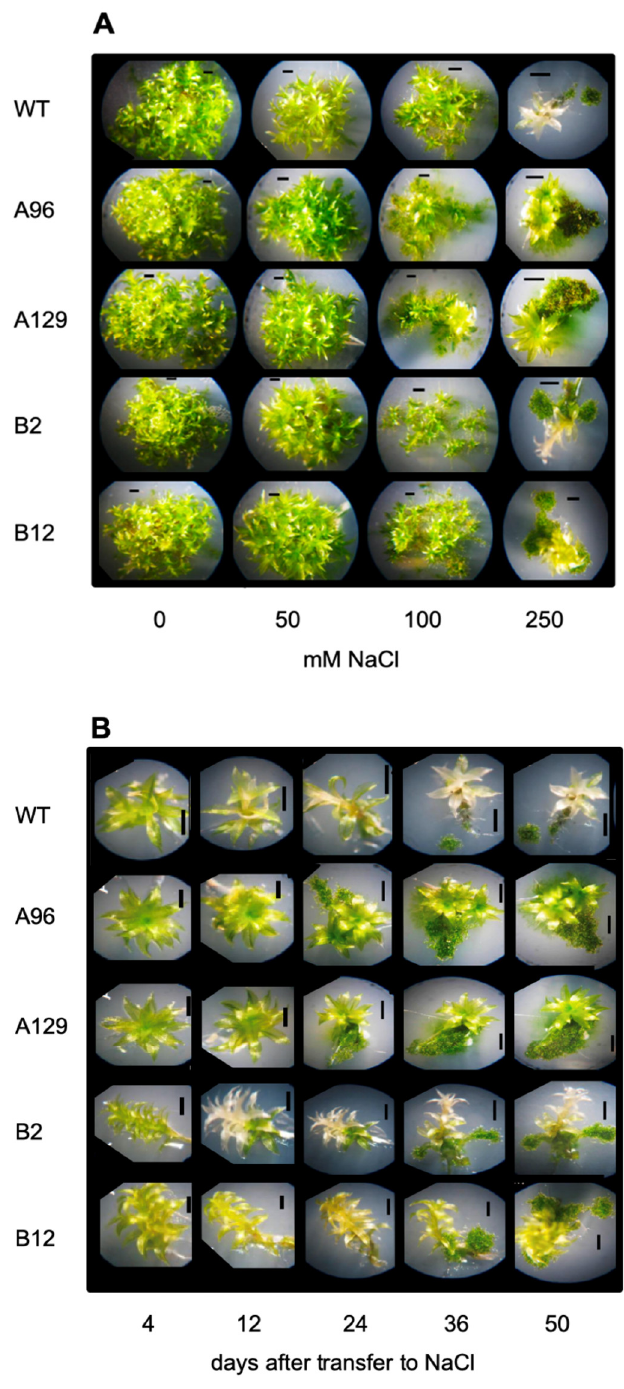
Figure 2. The growth of P. patens WT and four different double knock-out mutants in the two GH3 genes:.( A ) Different NaCl concentrations 50 days after transfer to salt-containing media. ( B ) Time course on 250 mM NaCl. Selected colonies are shown here in magnification. The pictures of the complete plates under the same conditions are shown in the supplement.